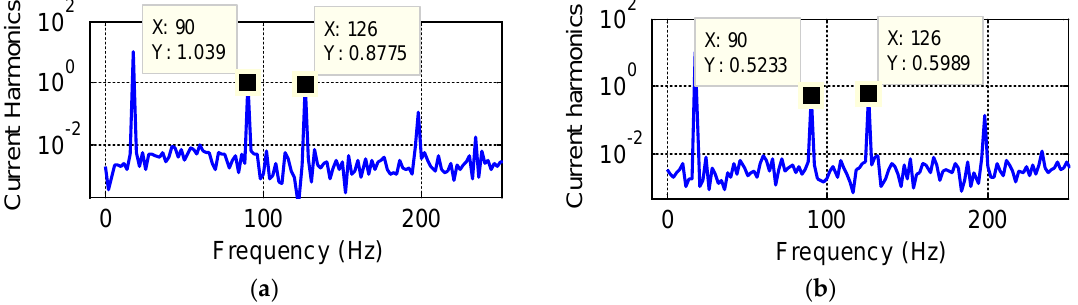
Figure 13. FFT results of phase current at 270 r/min: ( a ) Before suppression; ( b ) After suppression.